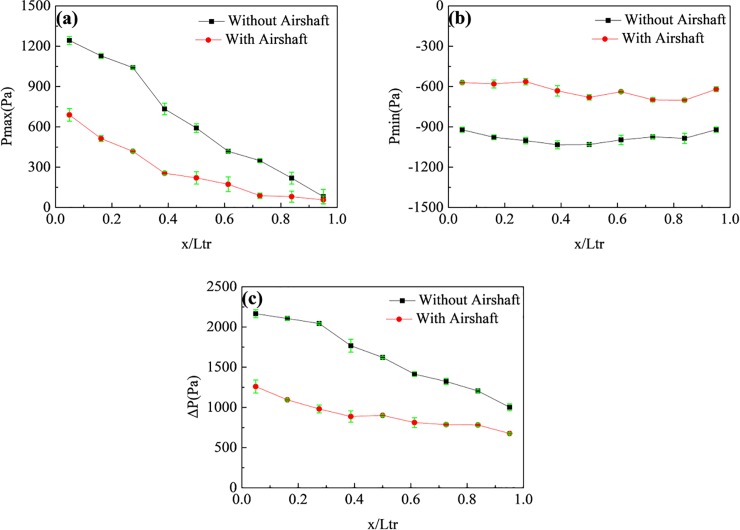
Pressures at different points on the train surface with and without an airshaft.(a), (b), and (c) show Pmax, Pmin, and ΔP, respectively.